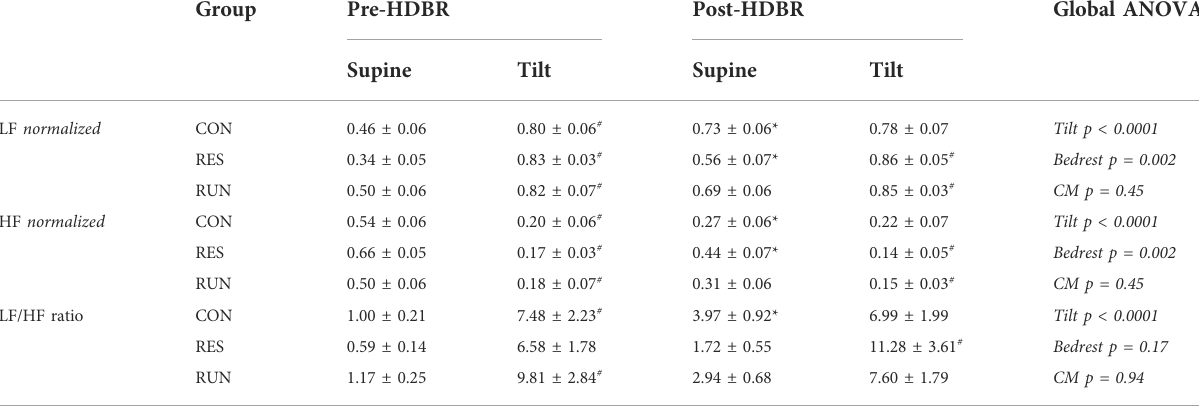
TABLE 2 HRV analysis results during the tilt